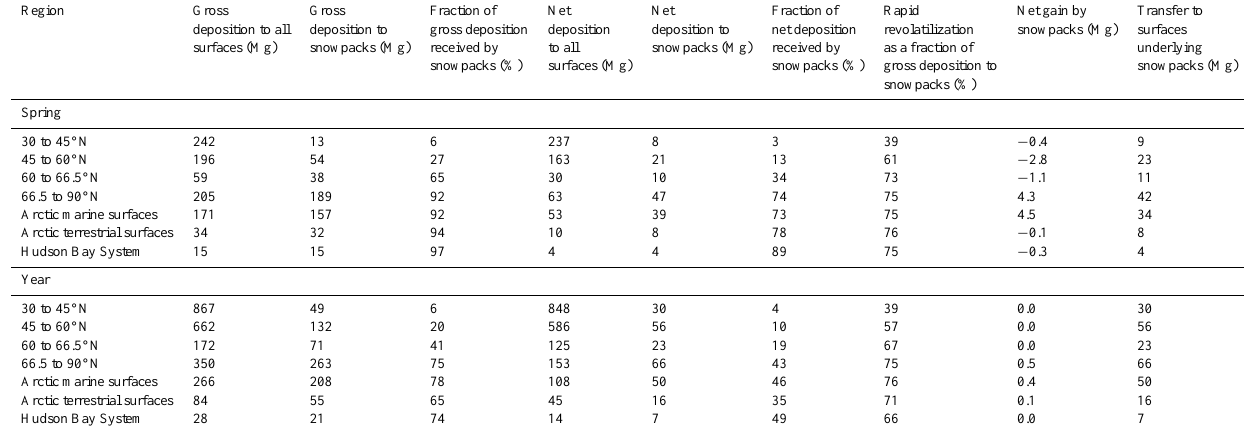
Table 3. Impact of snowpacks on deposition. Region Gross Gross Fraction of Net Net Fraction of Rapid Net gain by Transfer to deposition to all deposition to gross deposition deposition deposition to net deposition revolatilization snowpacks (Mg) surfaces surfaces (Mg) snowpacks (Mg) received by to all snowpacks (Mg) received by as a fraction of underlying snowpacks (%) surfaces